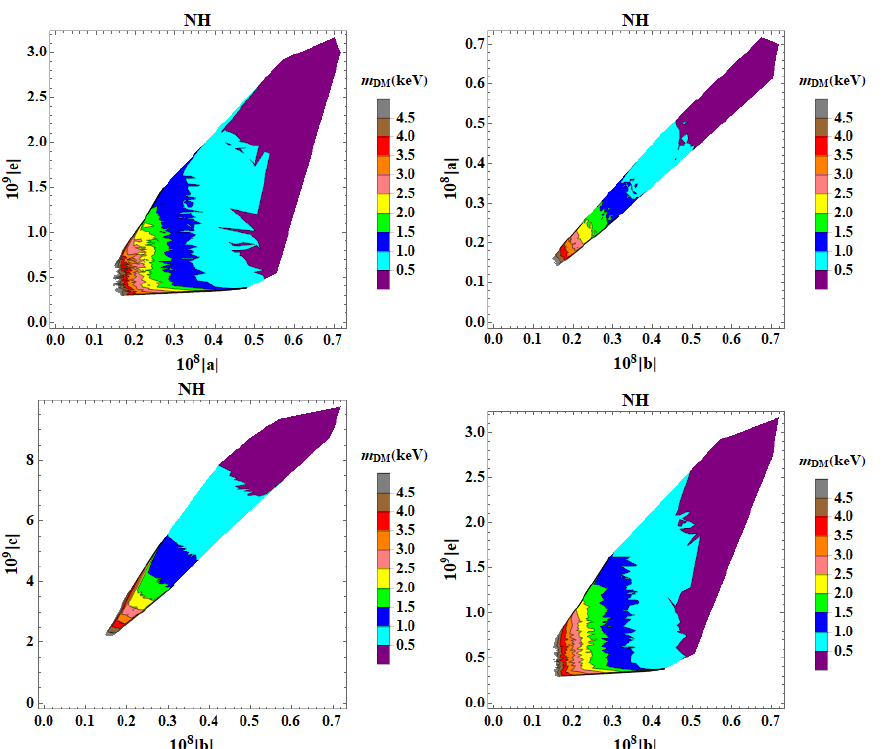
Figure 4 . Variation of di(cid:11)erent model parameters (in eV) with Dark Matter mass as a contour for normal hierarchy. The mass limit as predicted by cosmology is (0 : 4 (cid:0) 50)keV.